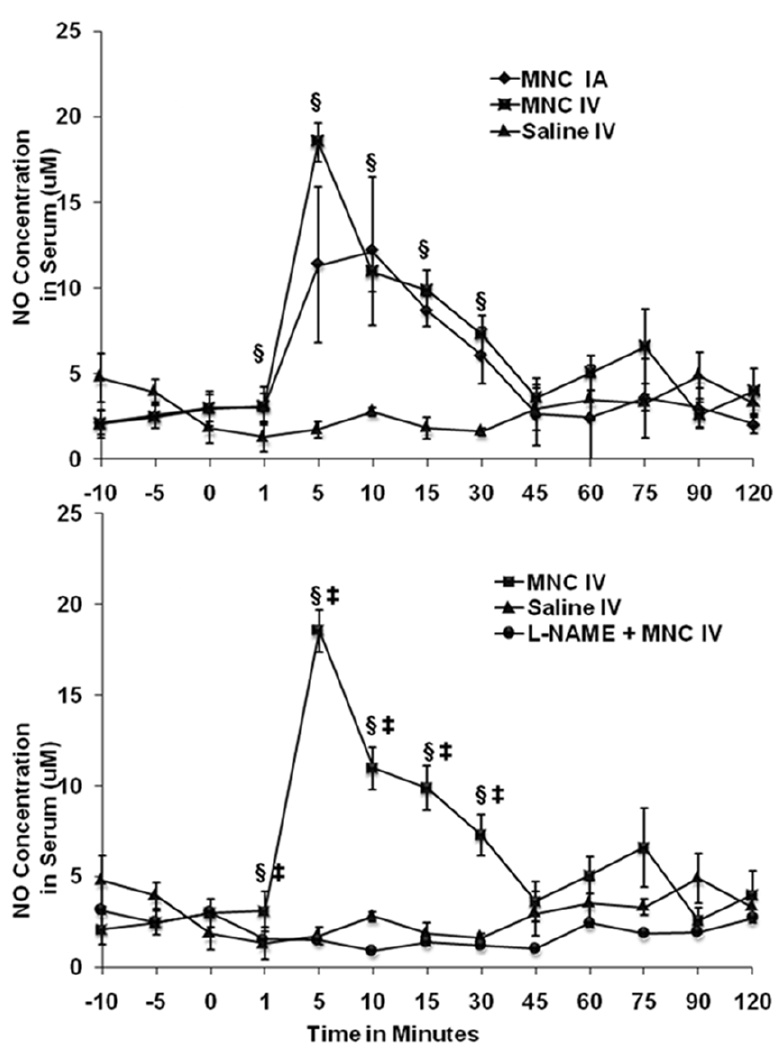
Figure 2. Time course of changes of NO at 24 hours after stroke. (A): Serum NO levels after saline or MNC (IV or IA) administered at 24 hrs post stroke. 1 p , 0.05 for IA or IV MNC treated groups compared with the saline treated group. Time zero refers to the time right before cell or saline injection. N=5 per group. (B): Serum NO levels in animals treated with L-NAME administered 60 min before MNC injection IV. 1 p , 0.05 refers to the MNC group compared with the saline group; { p , 0.05 refers to the MNC group compared with the L-NAME + MNC group. N=5 per group.